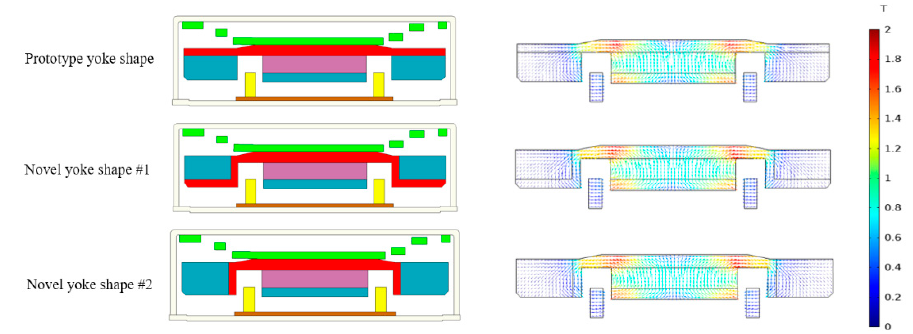
Figure 24. Novel yoke shapes and flux density distribution.